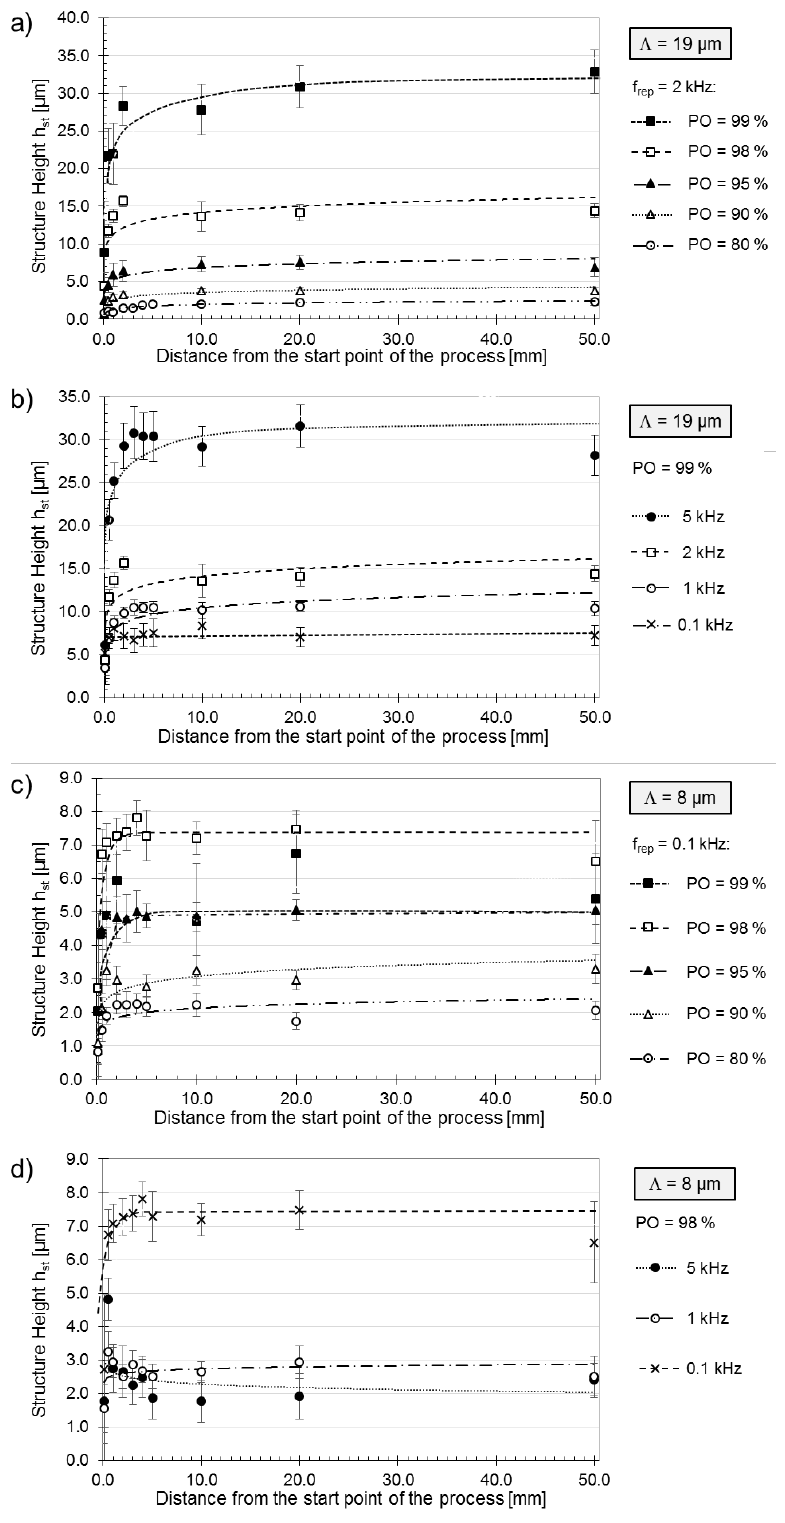
Figure 4. Evolution of the heights of trench patterns produced with DLIP: ( a ) Λ = 19.0 µ m, variation of PO at fixed rep. rate f rep = 2 kHz, ( b ) Λ = 19.0 µ m, variation of rep. rate at fixed PO of 98%, ( c ) Λ = 8.0 µ m, variation of PO at a fixed rep. rate f rep = 0.1 kHz, and ( d ) Λ = 8.0 µ m, variation of pulse repetition rate at fixed PO of 98%. Material: aluminum AlMg3. The laser fluence per pulse was 3.2 J · cm − 2